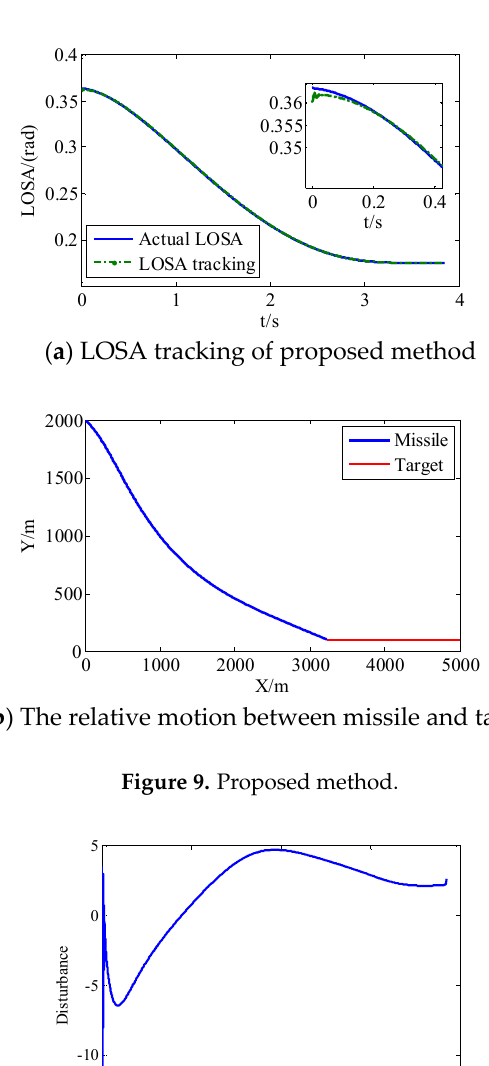
Figure 8. Method in Reference [33].